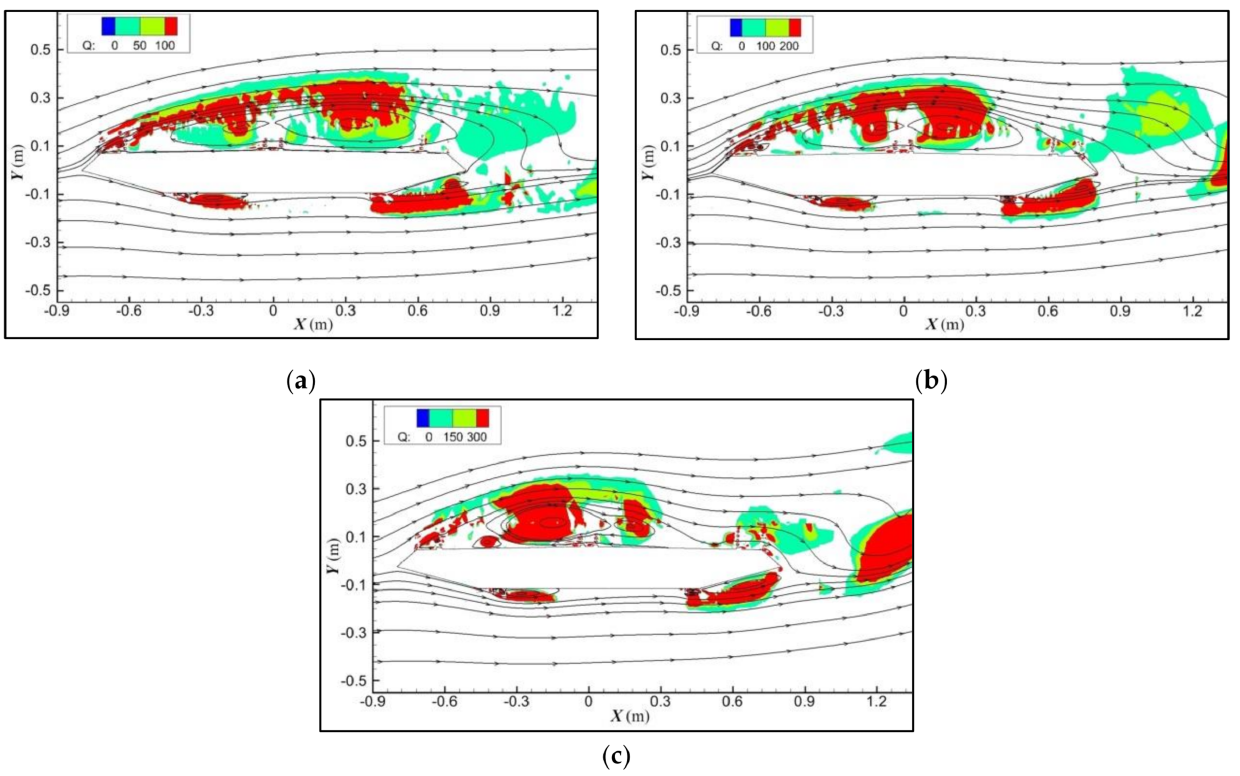
Figure 8. Contours of time-averaged vortex structures at 3 π /2 moment (Unit: s − 1 ). ( a ) Rapid development stage of VIV. ( b ) Gradual convergence stage of VIV. ( c ) Stable vibration stage of